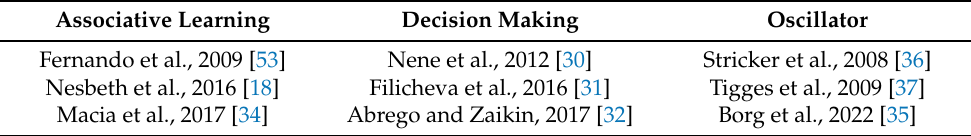
Table 1. Types of synthetic